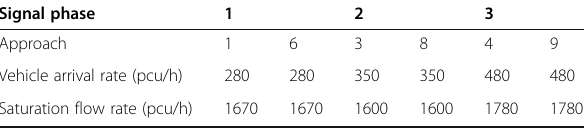
Table 1 Vehicle arrival rate and saturation flow rate of each approach Signal phase